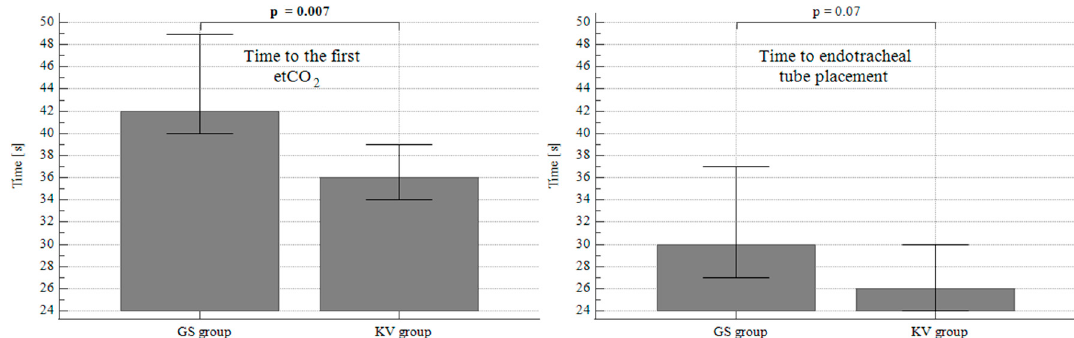
Figure 4. Di ff erence in time intervals to the first capnography and to tracheal tube placement.